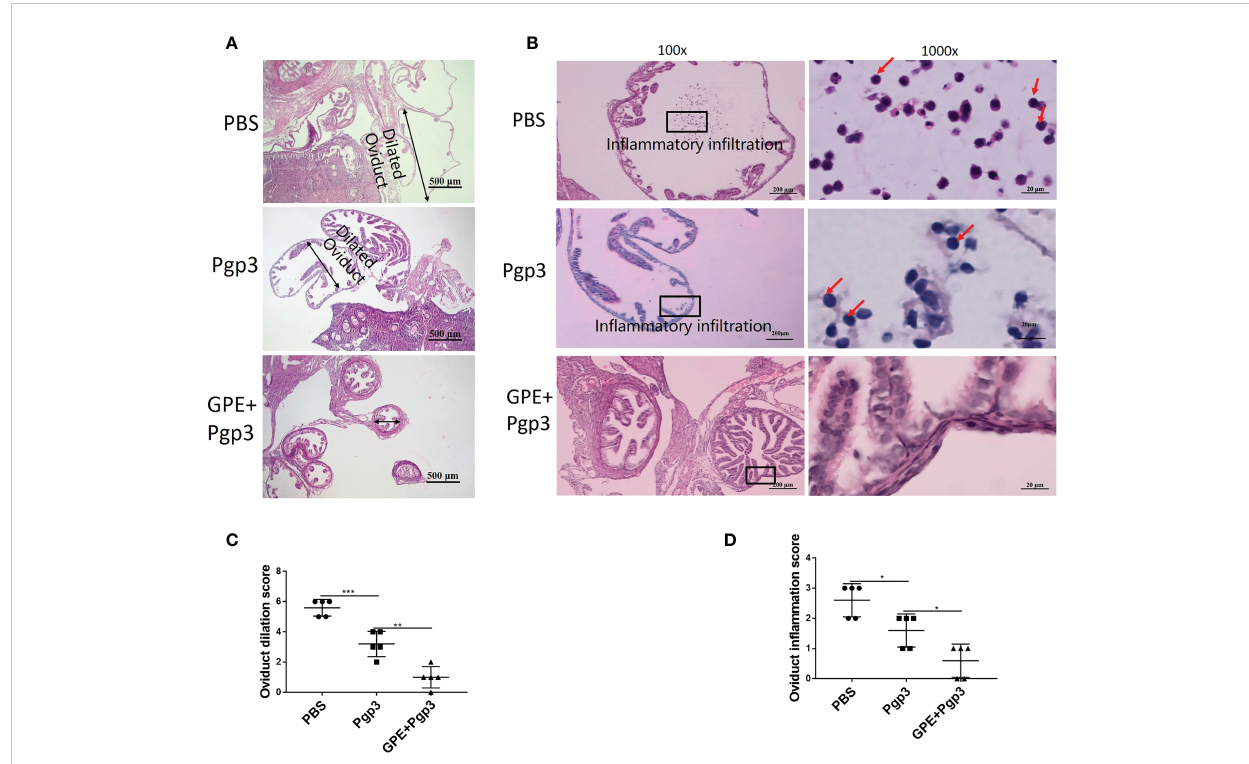
FIGURE 12 Microscopic observation of oviduct dilation and in fl ammatory in fi ltration. The oviduct tissues of vaccinated mice were harvested 60 days post Chlamydia muridarum ( C. muridarum ) infection and subjected to H&E staining. (A) Representative images of oviduct dilation. Images were magni fi ed ×50; (B) in fl ammatory in fi ltration of the oviduct with one representative image of a H&E stained oviduct from each group of mice presented in the left. The areas indicated by the black rectangles, covering the oviduct lumen, were magni fi ed and are shown on the right side of the corresponding images, with the in fl ammatory cells indicated by red arrows. Images were magni fi ed ×100 (left) and ×1,000 (right); (C) histograms of oviduct dilation scores; (D) oviduct in fl ammation scores. n = 5. H&E, hematoxylin and